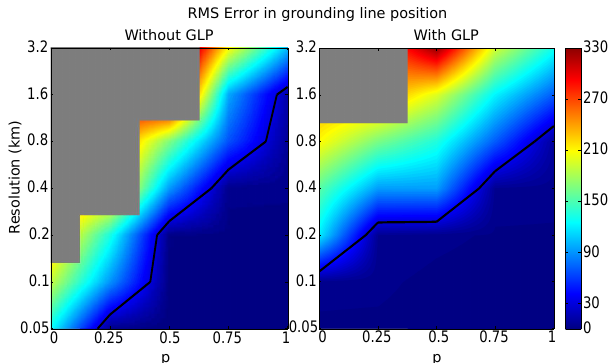
Figure 9. The root-mean-square (RMS) error between the fixed- grid and benchmark grounding-line position over a polynomial bed for simulation without the GLP (left column) and with the GLP (right column). The errors are bilinear interpolations of our 35 experiments. The gray area shows experiments that were not re- versible (i.e., for which the fixed-grid grounding line position did not retreat from region 3 to region 1 during the retreat experiment). The black line shows a contour of 30 km error, below which the error is deemed acceptable, as in Fig. 7. The RMS error without the GLP is approximately inversely proportional to the resolution and decreases strongly with increasing p . With the GLP, the RMS error is inversely proportional to the resolution and decreases, though less steeply, with increasing p